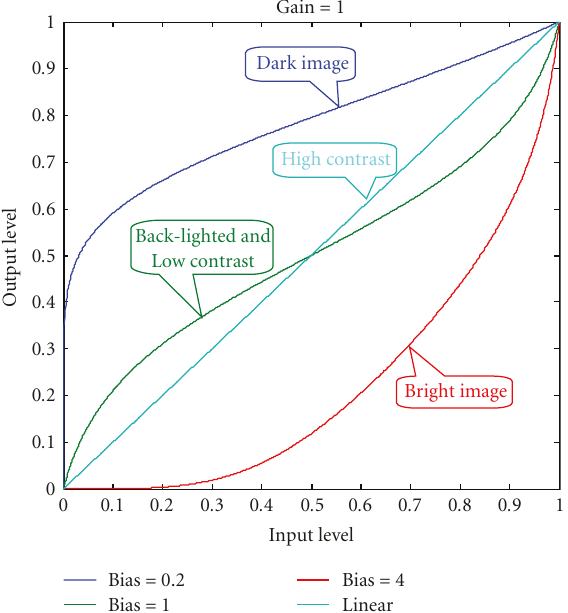
Figure 9: AIHT is approximately linear over the middle range values, where the choice of a semisaturation constant determines how input values are mapped to display